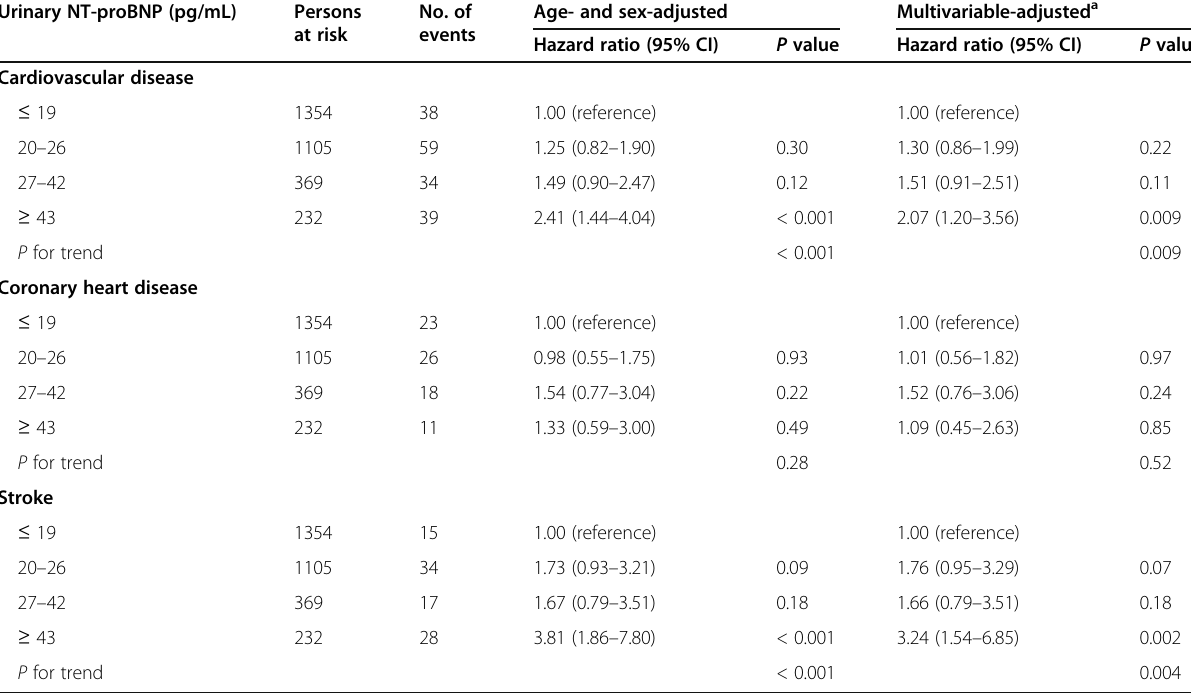
Table 2 Age- and sex-adjusted and multivariable-adjusted hazard ratios for the development of cardiovascular disease and its subtypes according to urinary NT-proBNP levels